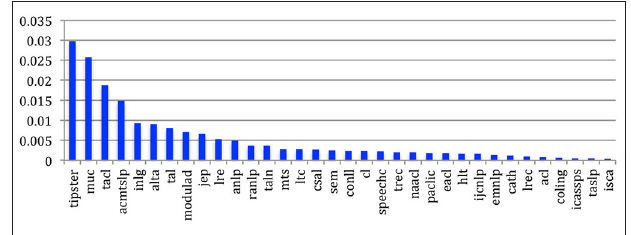
FIGURE 33 | Density of the CollG for the 34 sources.